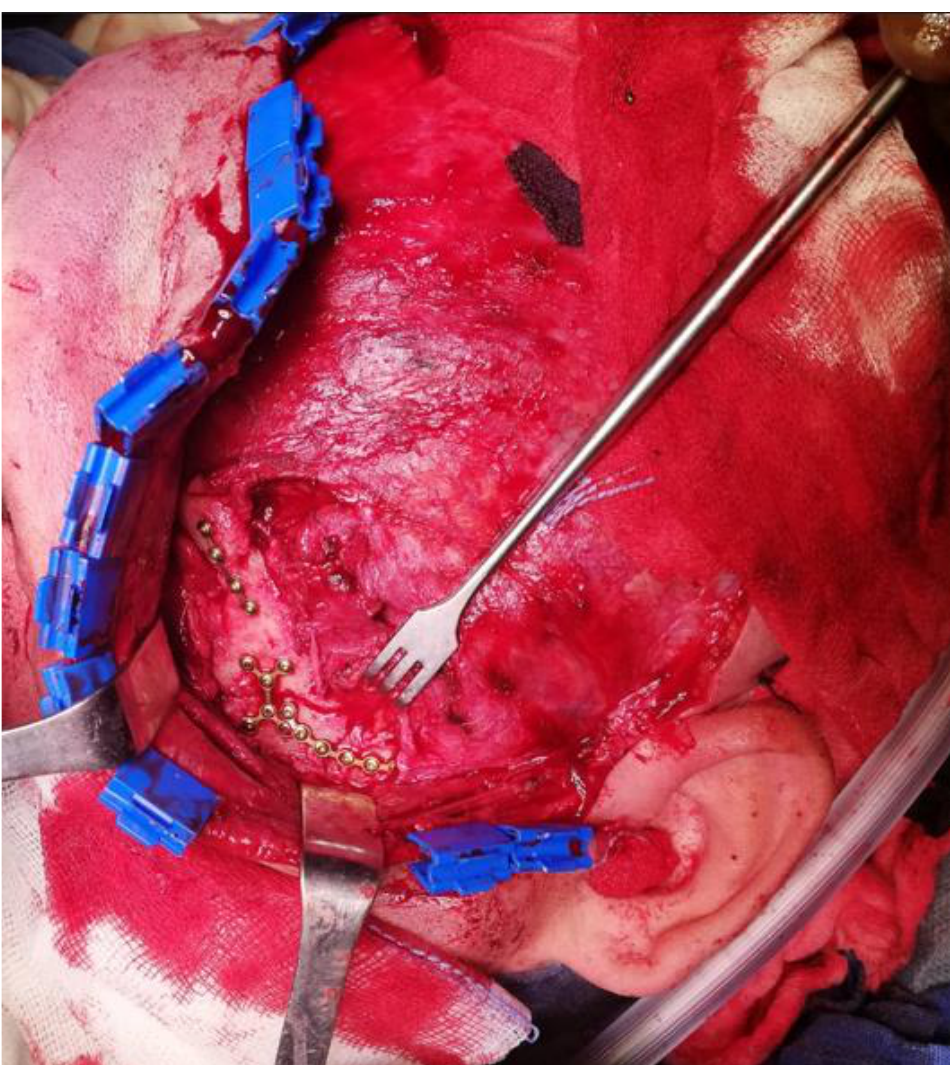
Figure 12. Intraoperative view after stable bone osteosynthesis via a hemicoronal approach.